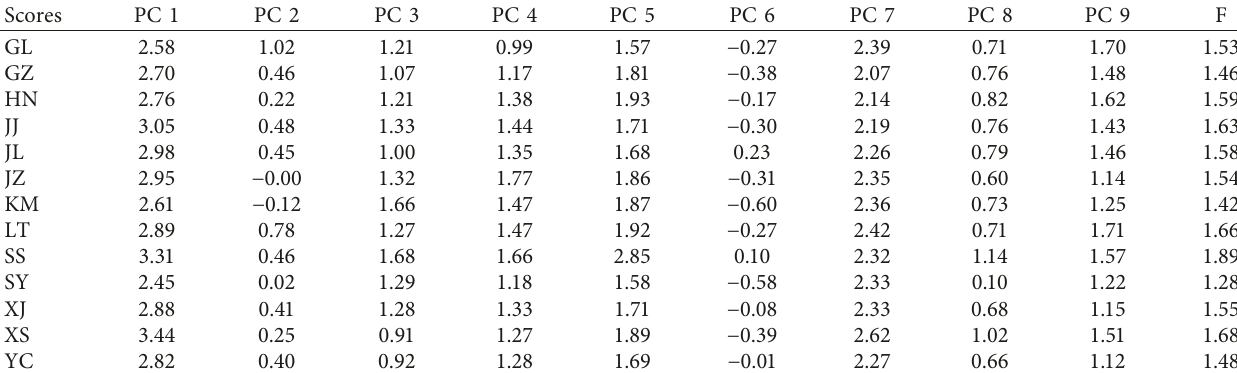
Table 4: Principal component scores and comprehensive scores of thirteen Lycium chinense